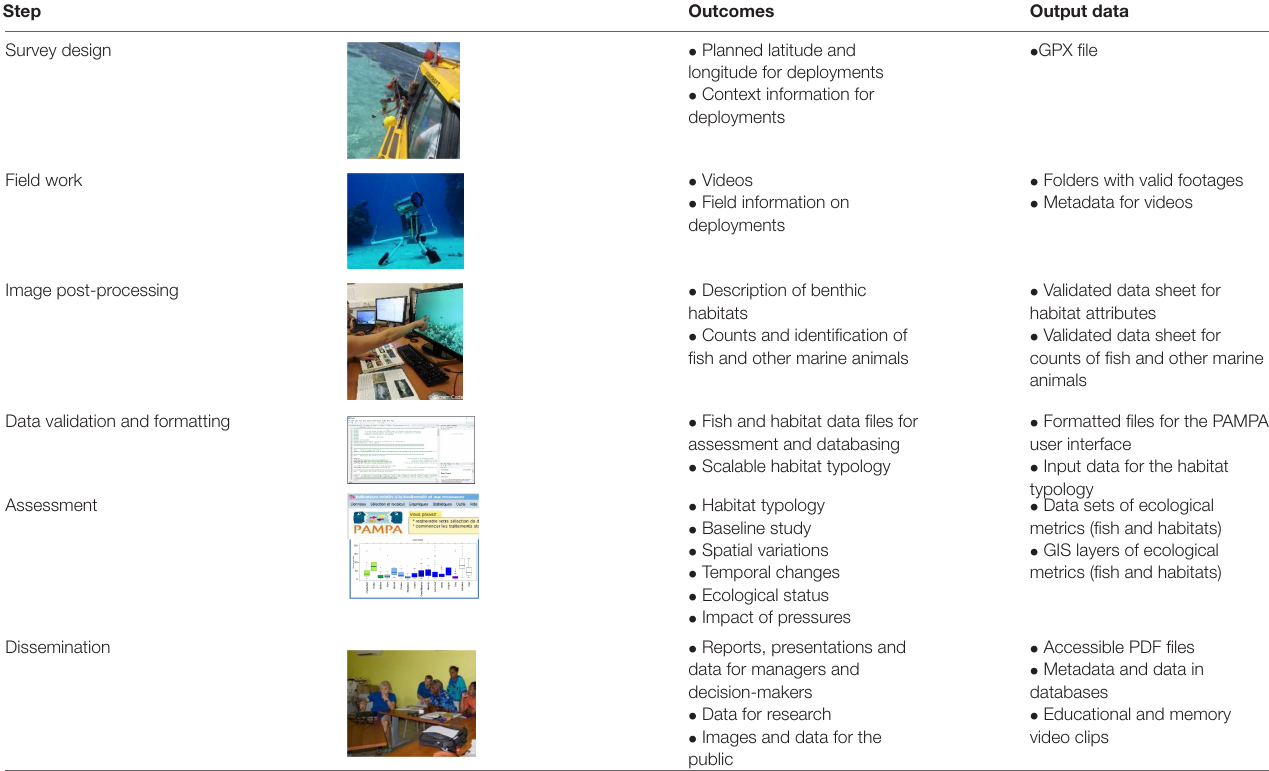
TABLE 1 | Steps of the workflow with corresponding outcomes and output